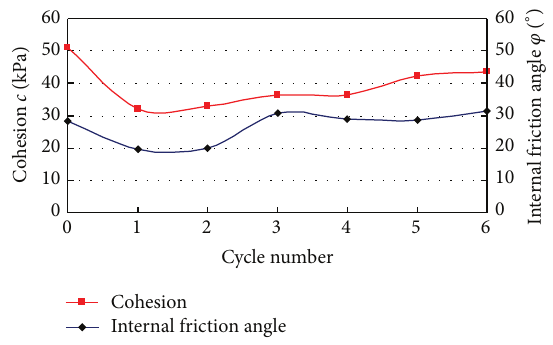
Figure 9: Relationship between the shearing strength parameters and cyclic number.